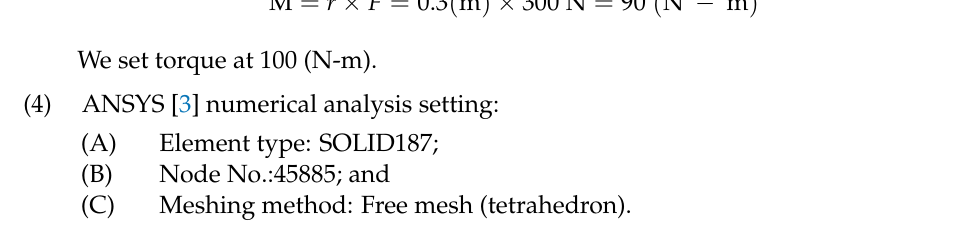
Table 1. Design parameters and limitations.